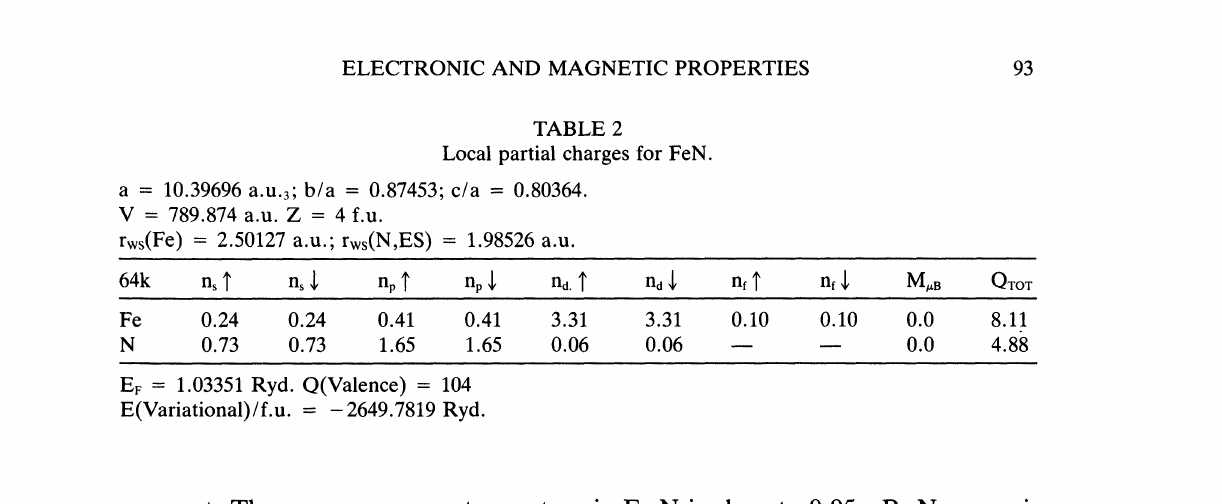
Local partial charges for